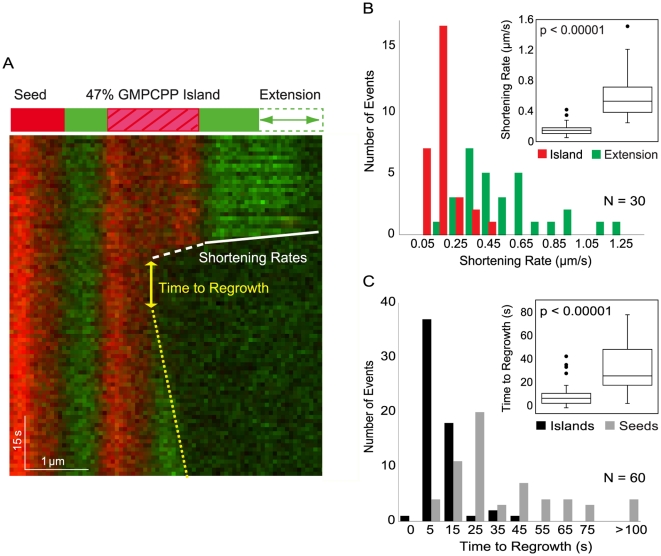
Island dynamics are distinct from GDP-tubulin extensions and GMPCPP seeds.(A) Shortening rates of GDP-tubulin extensions (white solid line) and GXP islands (white dashed line) and the time to microtubule regrowth (yellow double arrow measured from extrapolated yellow dotted line) were measured from kymographs of depolymerizing microtubules. (B) GXP islands shorten more slowly than GDP-tubulin extensions. Distribution of shortening rates measured for extensions and islands (N = 30). The inset shows a box-plot of the data, which has a median shortening rate of 0.49 µm/s for extensions and 0.16 µm/s for islands (p<0.00001, Wilcoxon rank-sum test). Only cases where extension and island shortening could both be measured in the same depolymerization event were analyzed. (C) Microtubules grow more readily from islands than from GMPCPP seeds. Time to regrowth was measured from kymographs of dynamic microtubules and was on average shorter from islands than from GMPCPP seeds. Median time to regrowth was 6 seconds for GXP islands (N = 60) and 27 seconds for GMPCPP seeds (N = 60) (inset, p<0.00001, Wilcoxon rank-sum test; outliers >100 are not shown).